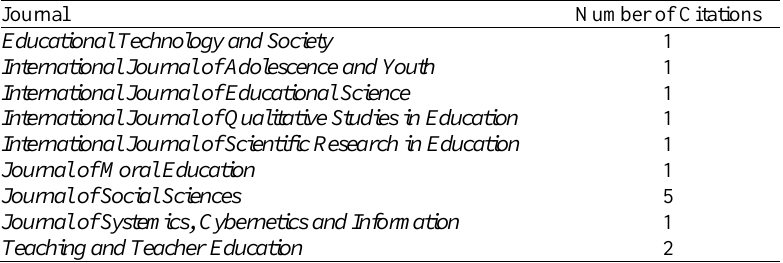
Table 6 International journals in which self-citations are to be found from doctoral research completed in fields of education in South Africa in